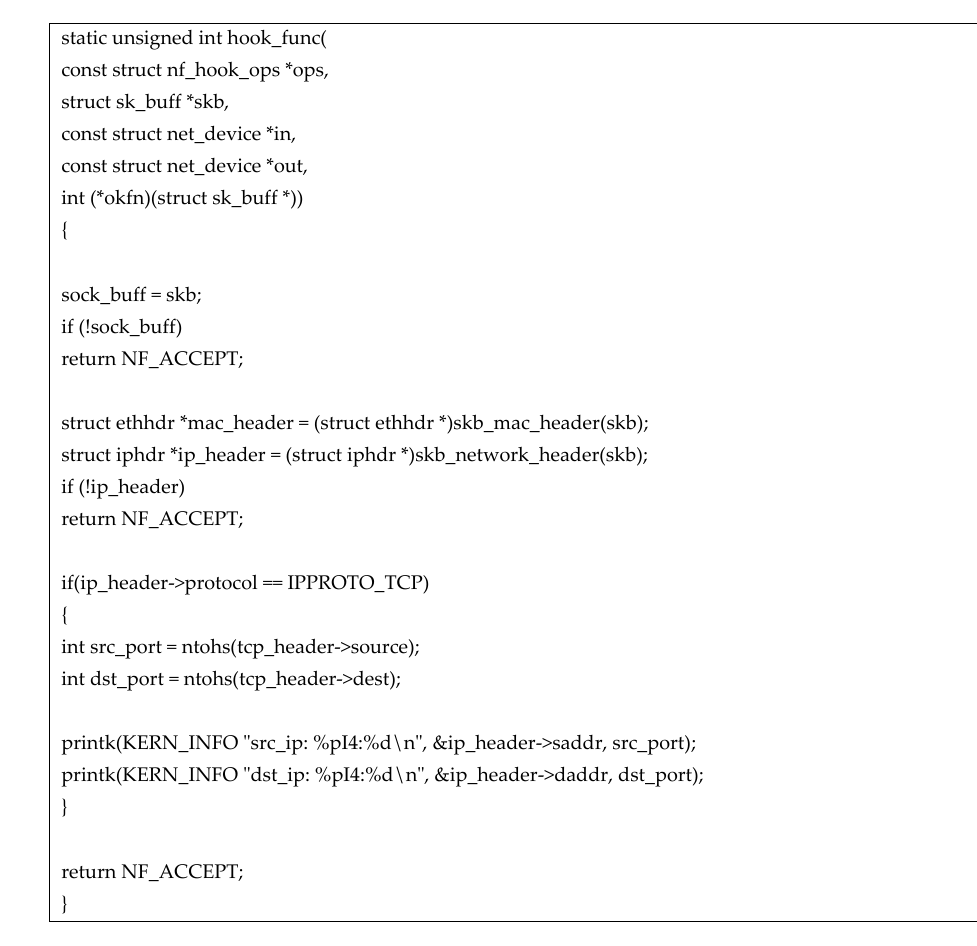
Figure 9. Example code of acquiring packets using Netfilter hooks.